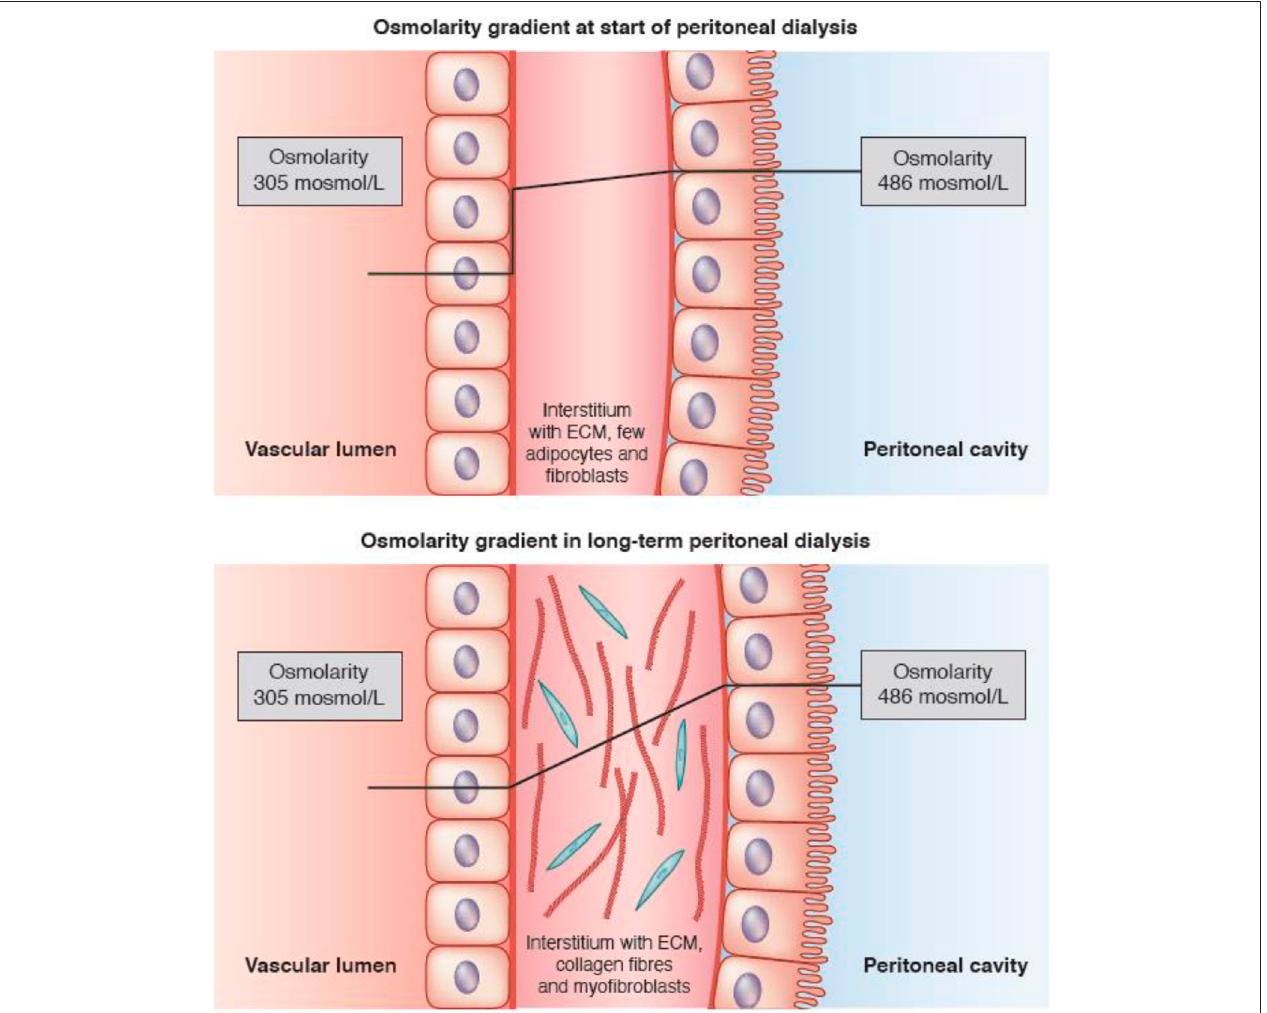
FIGURE 1 | Schematic representation of the crystalloid osmotic gradient across the peritoneal interstitium in the fi rst few years of peritoneal dialysis, when only a small amount of fi broblasts is present (upper panel), and the situation in long-term peritoneal dialysis, where the gradient decreases in the interstitium due to cellular uptake of glucose (lower panel). Aquaporin-1 (AQP-1) is present in some endothelial cells. The lines show the estimated time-course of the crystalloid osmotic pressure gradient between the dialysate- fi lled peritoneal cavity and the blood. Note that the pressure gradient remains almost stable during the passage of fl uid through the interstitium in patients at the start of PD, resulting in a high gradient for AQP-1 (upper panel), but decreases in long-term PD patients due to uptake of glucose by interstitial myo fi broblasts, leading to a lower crystalloid osmotic pressure gradient (lower panel). Taken from Krediet (2021) with permission of the American Society of